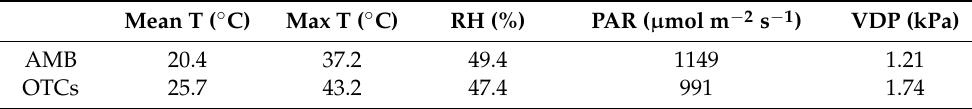
Table 2. Mean meteorological conditions during the experimental assay for the 8-h daylight period 7:00–15:00 (GMT) inside the OTCs and in the AMB plots. Mean and maximum air temperature (mean T, max T), air relative humidity (RH), photosynthetic active radiation (PAR) and vapor pressure deficit (VPD,